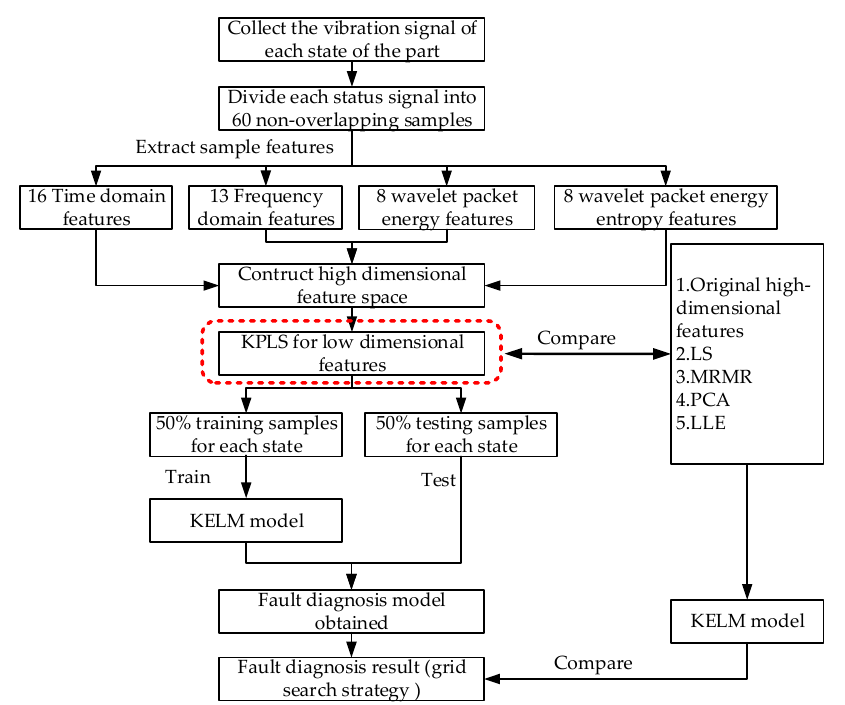
Figure 2. The realization process of KPLS − KELM flow chart.